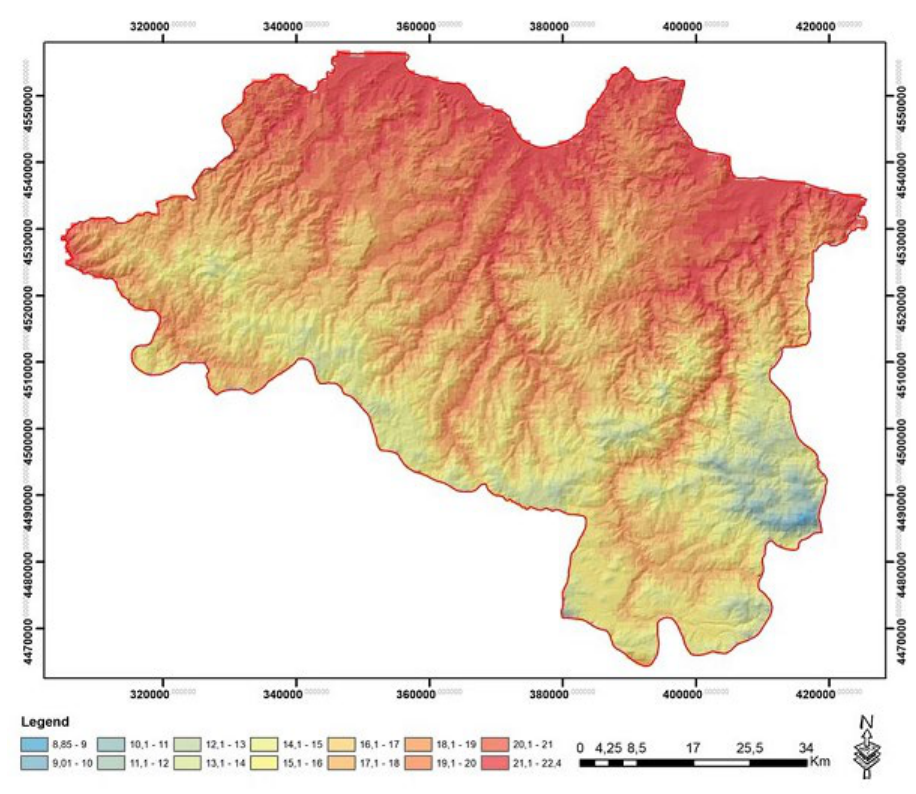
Figure 3 Average Temperature in Ordu Province in Summer (Alrabiti 2023) When the map showing the average temperature in the summer months is examined, it is seen that the warmest parts of the province are generally the northern parts, the average temperature decreases from the north to the south, and the coolest parts of the province are the southwest. According to the calculations, the average temperature in summer is below 13 °C in approximately 2.88% of the province and above 20 °C in 24.91% of the province. In approximately 14.31% of the province, the temperature is between 16-17 °C. By using the values of humidity and temperature, the values of SSI and belts were evaluated throughout the city, and the comfort status for the summer months is given in Figure